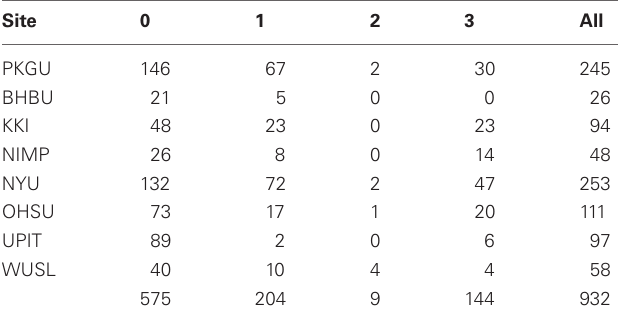
Table 1 | Subjects distribution of the ADHD-200 dataset with respect to the